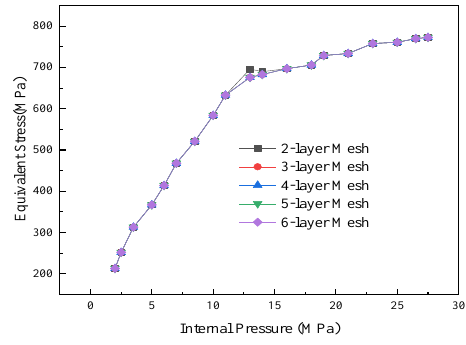
Figure 1. Sensitivity of the mesh.